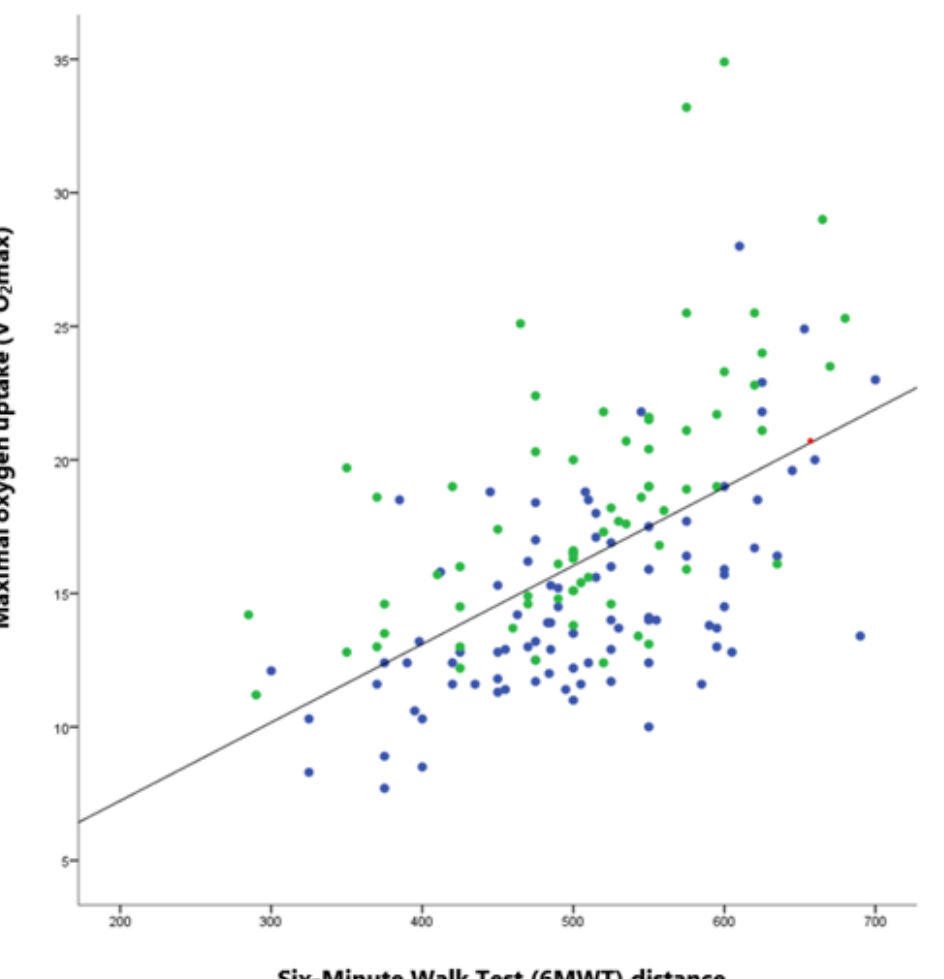
Figure 1. The relationship between matrix maximal oxygen uptake (V’O 2 max) measured during the exercise test and the Six-Minute Walk Test (6MWT) distance by level exercise capacity (linear regression modelling). Legend: Green points for normal exercise capacities: Maximal result of exercise test is greater or equal to 80% of the reference value. Blue points for lower exercise capacities: Maximal result of exercise test is less than 80% of the reference value.